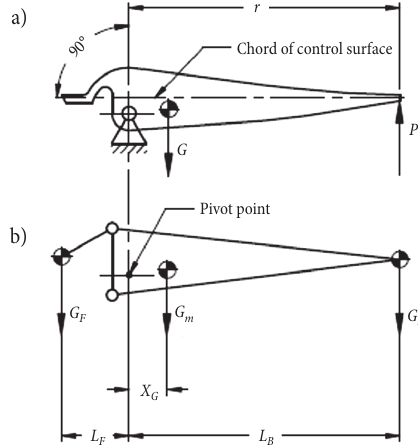
Fig. 3. Modelling of control surfaces: a – real control surface; b – finite element model